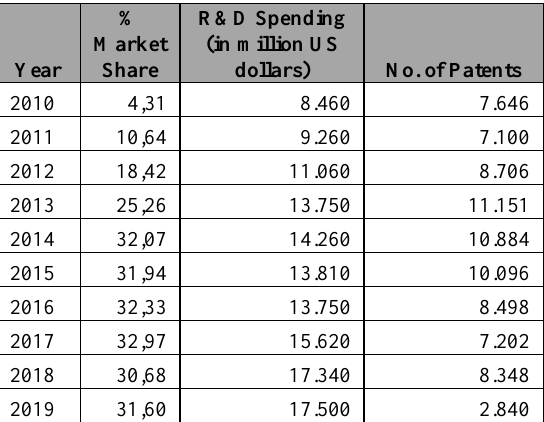
Table 6: Samsung Ten Years Data